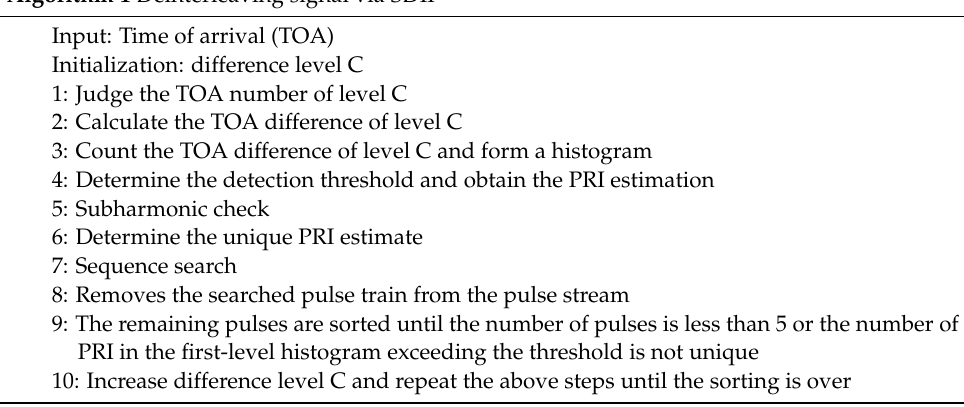
Algorithm 1 Deinterleaving signal via